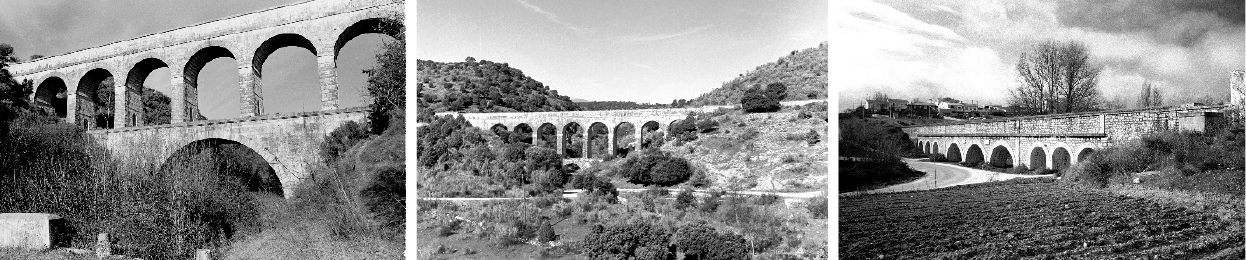
Figure 6. Canal Bajo Aqueducts: La Sima Aqueduct (1855), La Retuerta Aqueduct (1855) and El Espartal Aqueduct (1852). Source: FMA.